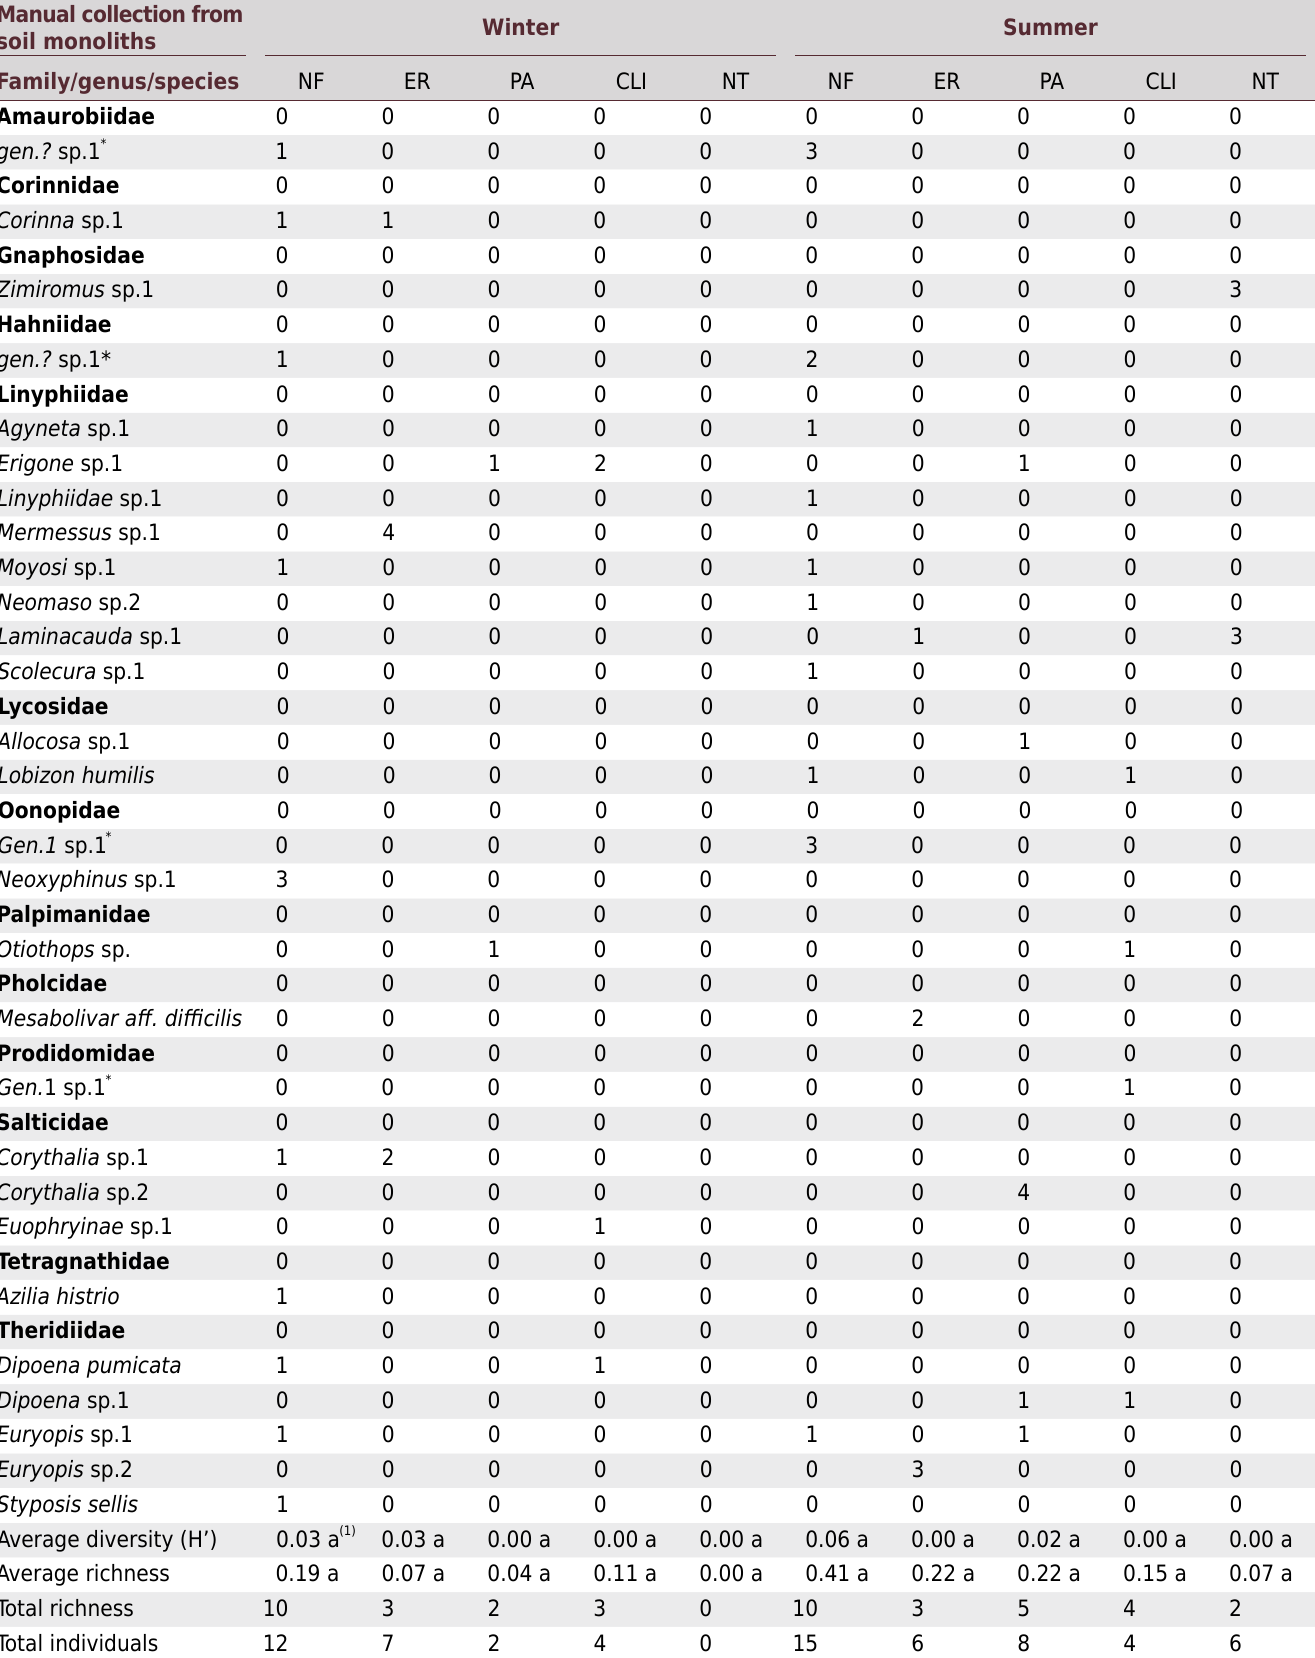
Table 5. The total number of individuals (spider families) captured in western Santa Catarina by manual capture in soil monoliths in two contrasting seasons (winter and summer) in native forest (NF), eucalyptus reforestation (ER), pasture (PA), crop-livestock integration (CLI), and no-tillage annual crops (NT) Manual collection